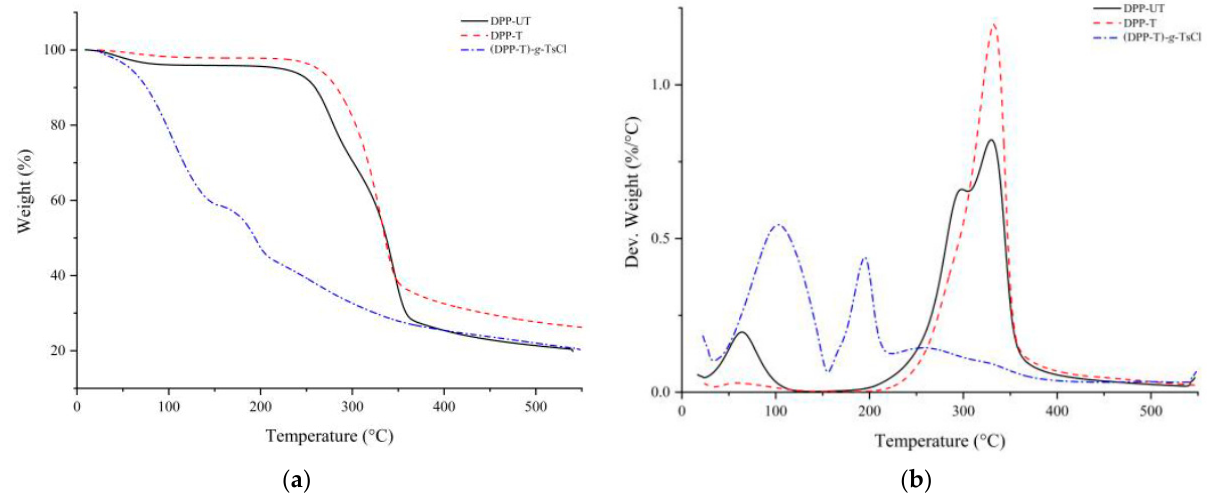
Figure 12. (a) TGA and (b) DTG curves of DPP-UT, DPP-T, and (DPP-T)- g -TsCl. Figure 12. ( a ) TGA and ( b ) DTG curves of DPP-UT, DPP-T, and (DPP-T)- g